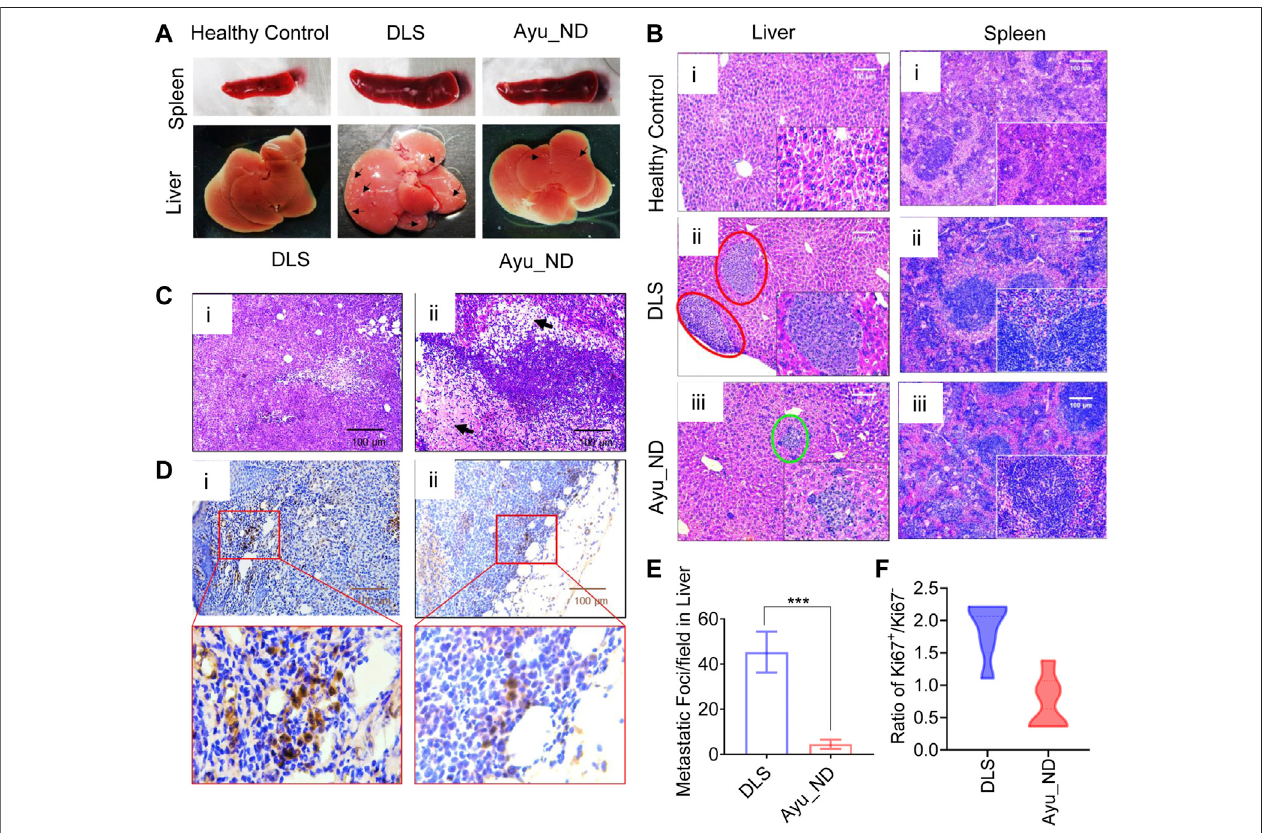
FIGURE 6 | Histopathological features of Ayu_ND-treated animals show disease protective potential. Macroscopic liver metastatic nodule distribution in the dissected organs (indicated with black arrow) (A) . Representative H&E-stained livers (i – iii) and spleens (i – iii) collected from healthy control, untreated and treatment groups at day 22 and labeled metastaticfoci areas indicated with red circles for DLS and green circles with Ayu_ND treatment (B) . H&E-stained sections ofsolid tumors (C) . Staining of solid tumor sections with anti-mouse Ki67 antibodies for detecting dividing cells for comparisons between the untreated and Ayu_ND-treated groups (D) .Quantitative estimation ofmetastatic fociinthe liversofuntreated and treatedmice (E) .Ratios ofKi-67+/Ki-67 − tumor cells inthesolidtumor massbetween the treated and untreated groups (F) . Data represent the mean ± SE of n = 3 or 4 animals per group. NS no signi fi cance; * p < 0.05, ** p < 0.01, *** p < 0.001, and **** p <